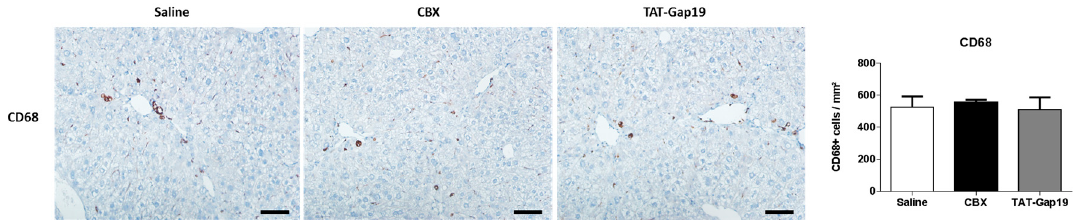
Figure 5. Effects of CBX and TAT-Gap19 on the inflammatory response after TAA-induced chronic hepatic injury in mice. Mice were administered TAA intraperitoneally for 8 weeks. Initially, mice ( n = 5/group) were administered with 100 mg TAA/kg body weight, followed by 10% weekly increments to the utmost dose of approximately 200 mg TAA/kg body weight. Thereafter, an osmotic pump was implanted in the peritoneal cavity, which ensured the release of 1 mg TAT-Gap19 or CBX/kg body weight/day or saline for two weeks. Macrophage abundance was determined by quantification of CD68 immunostaining in liver tissue. At least 10 randomly selected fields were quantified from the left lobe of each animal. Results were analyzed by 1-way ANOVA followed by post hoc Bonferroni correction. Data were expressed as means ± SEM. Scale bar represents 50 μ m.